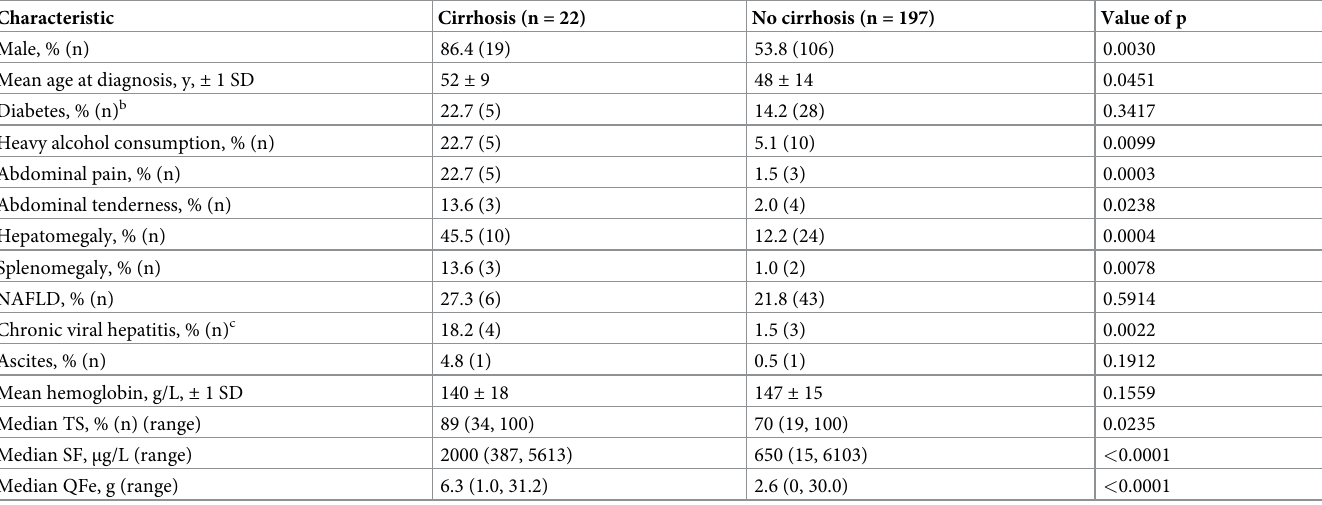
Table 1. Characteristics of 219 hemochromatosis probands with HFE p.C282Y homozygosity a . Characteristic